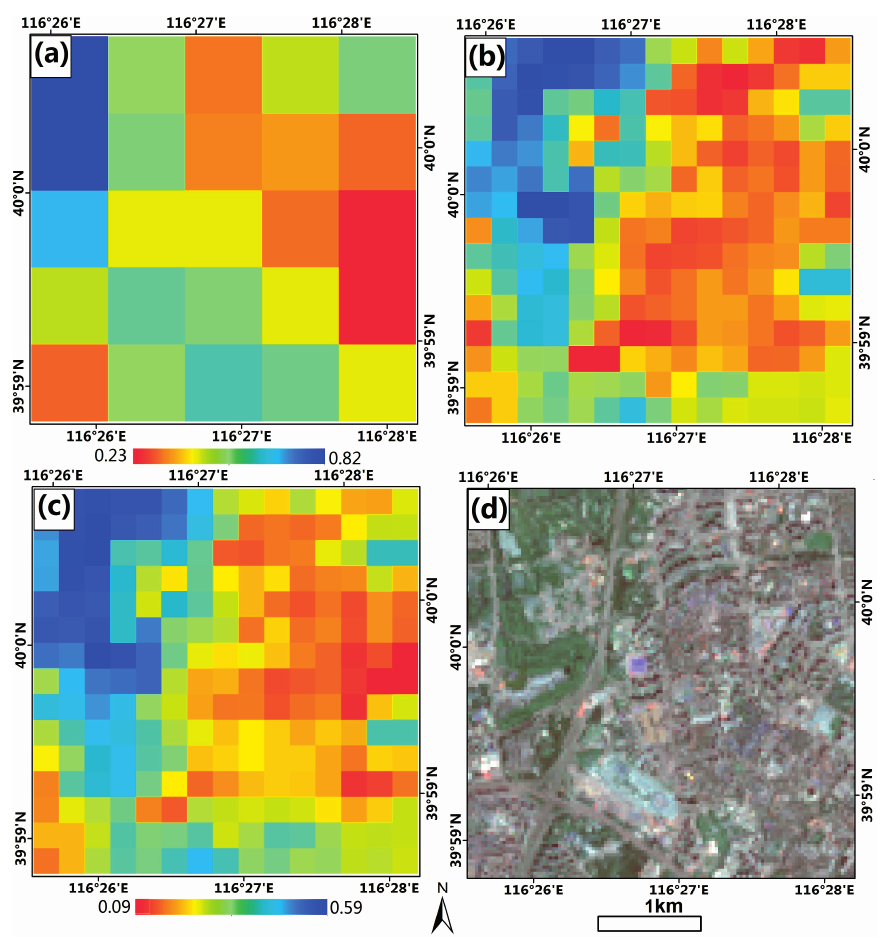
Figure 4. A comparison of four datasets in Beijing City; ( a ) VIIRS-DNB with 750 m spatial resolution; ( b ) 1-NDVI max with 250 m spatial resolution; ( c ) LISI with improved spatial resolution (250 m); and ( d ) Landsat 8 OLI color composite with 15 m spatial